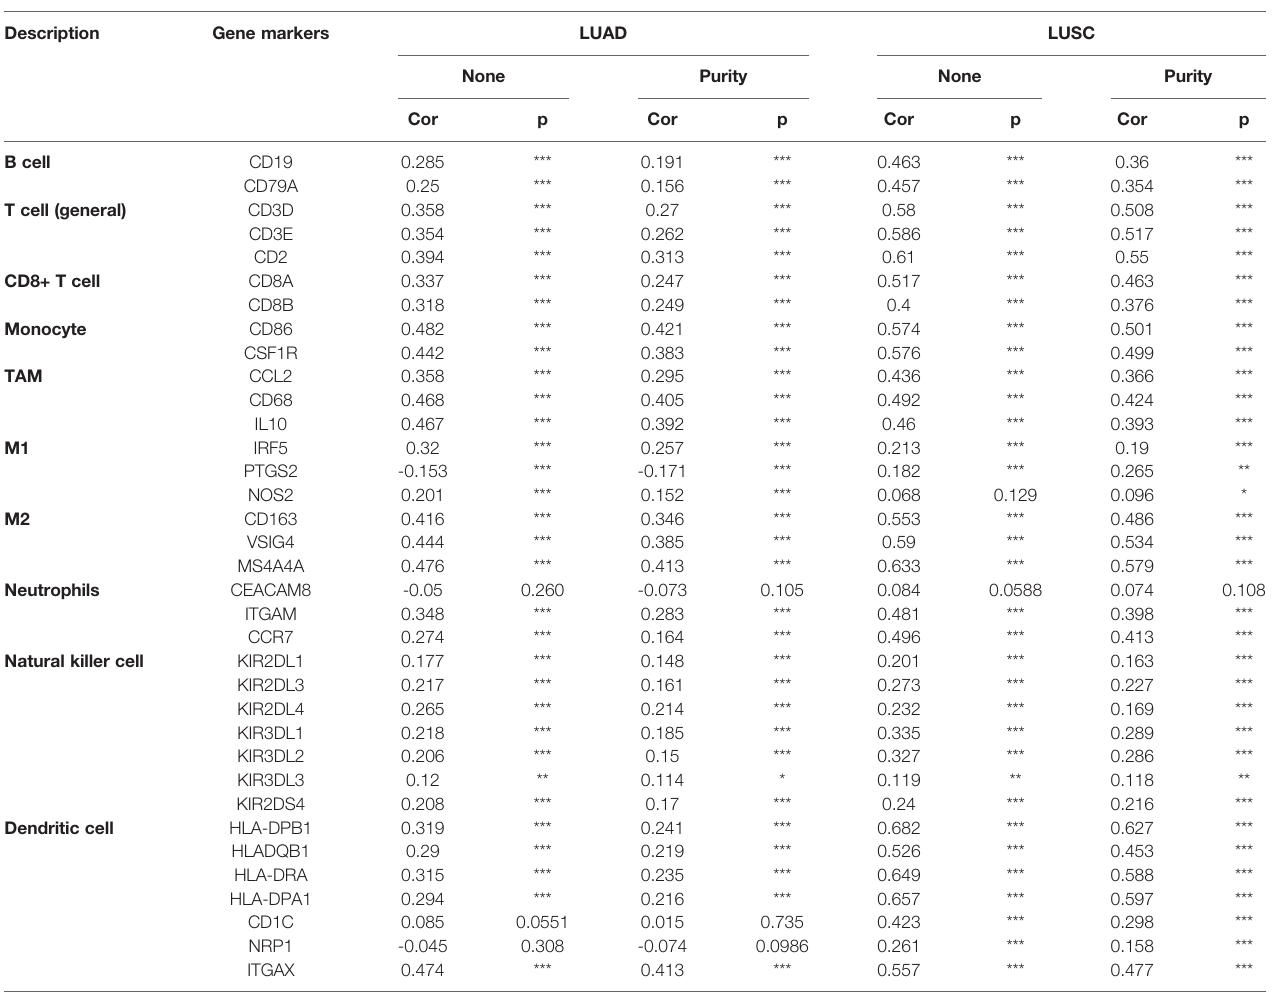
TABLE 1 | Correlation analysis between hepcidin and gene markers of immune cells in TIMER. Description Gene markers LUAD